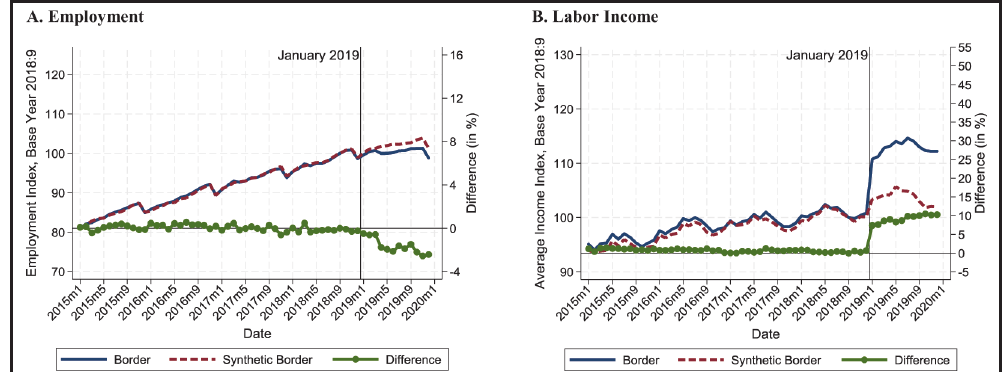
Figure 2 Synthetic control method (SCM) results,